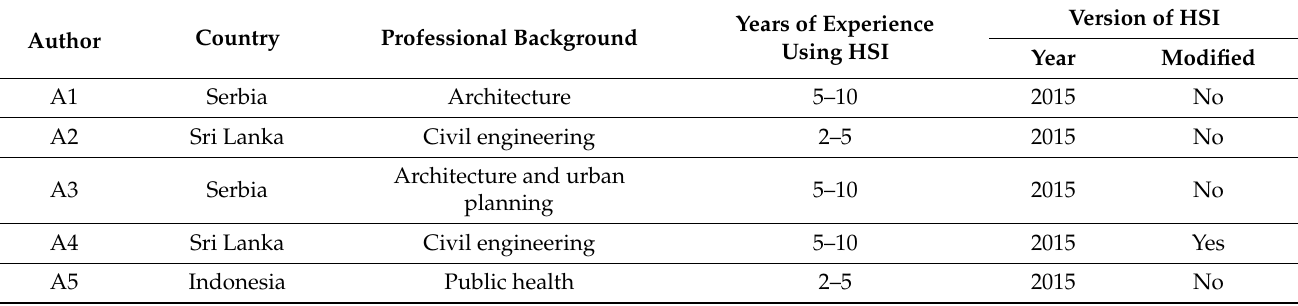
Table 1. Overview of the demographics of the